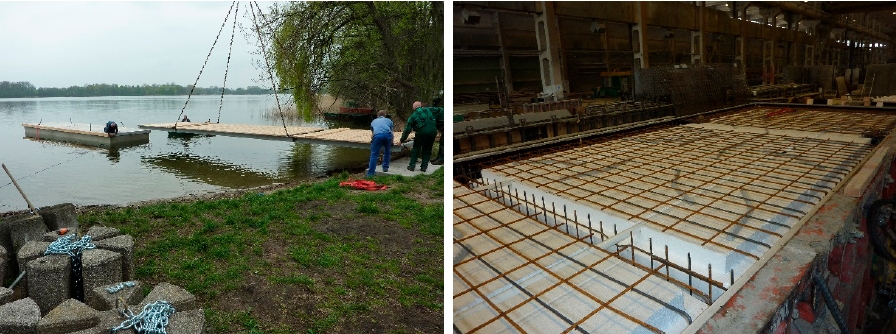
Figure 9. The pontoon during execution with visible reinforcement and a partition in the centre ( left ) and during launching ( right ).